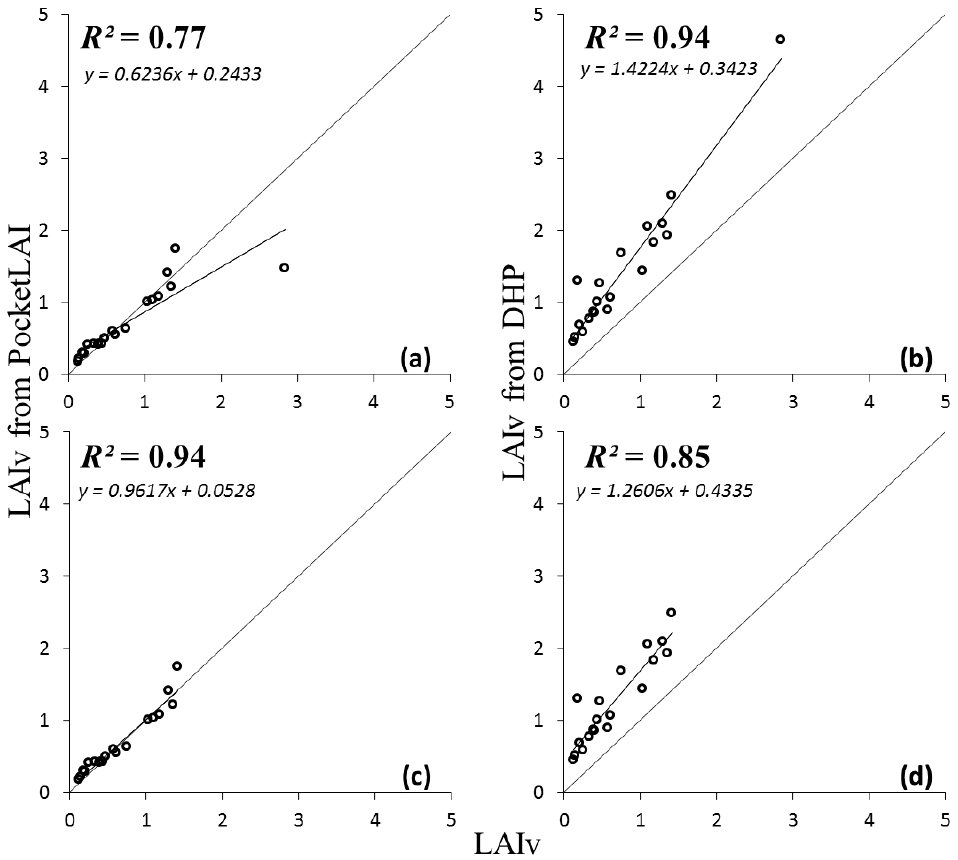
Figure 2. Agreement between LAIv data observed with direct measurement and those estimated with PocketLAI ( a , c ) and hemispherical photography (DHP) ( b , d ); considering the whole dataset (Dataset-1; a , b ) and excluding the outlier value of a very high-vigour sampling area (Dataset-2; c , d ).